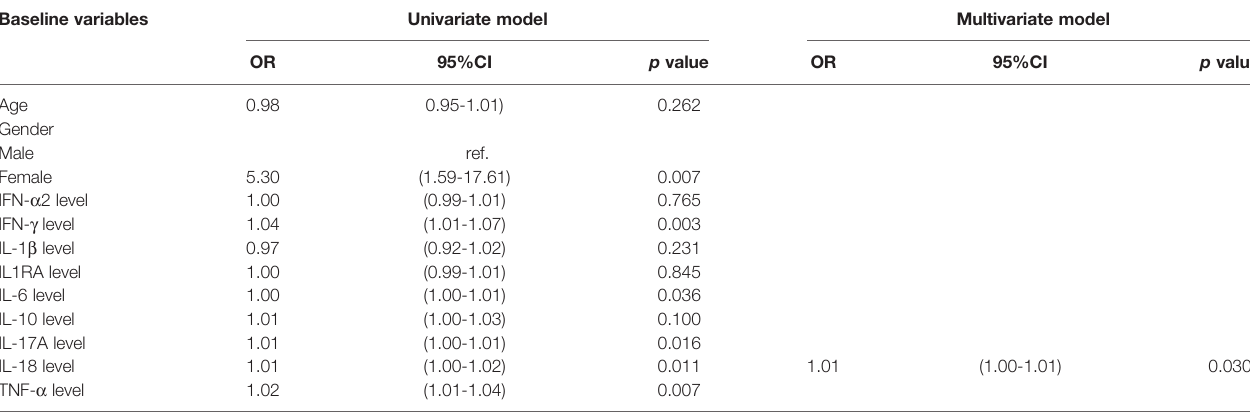
TABLE 3 | Logistic regression analysis of cytokine pro fi les to predict active AOSD in the studied cohort. Baseline variables Univariate